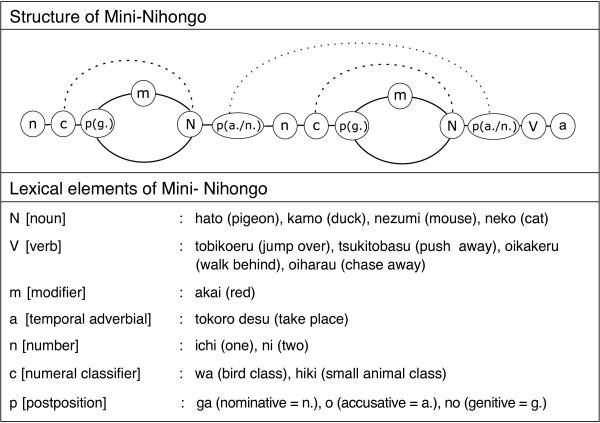
Schematic representation of structure and lexicon of Mini-Nihongo (illustration adapted from [35]). The nodes in the upper box denote word classes, solid lines mark legal transitions between elements of the classes, and dotted lines indicate dependencies between specific class members. Sentences are generated from left to right.